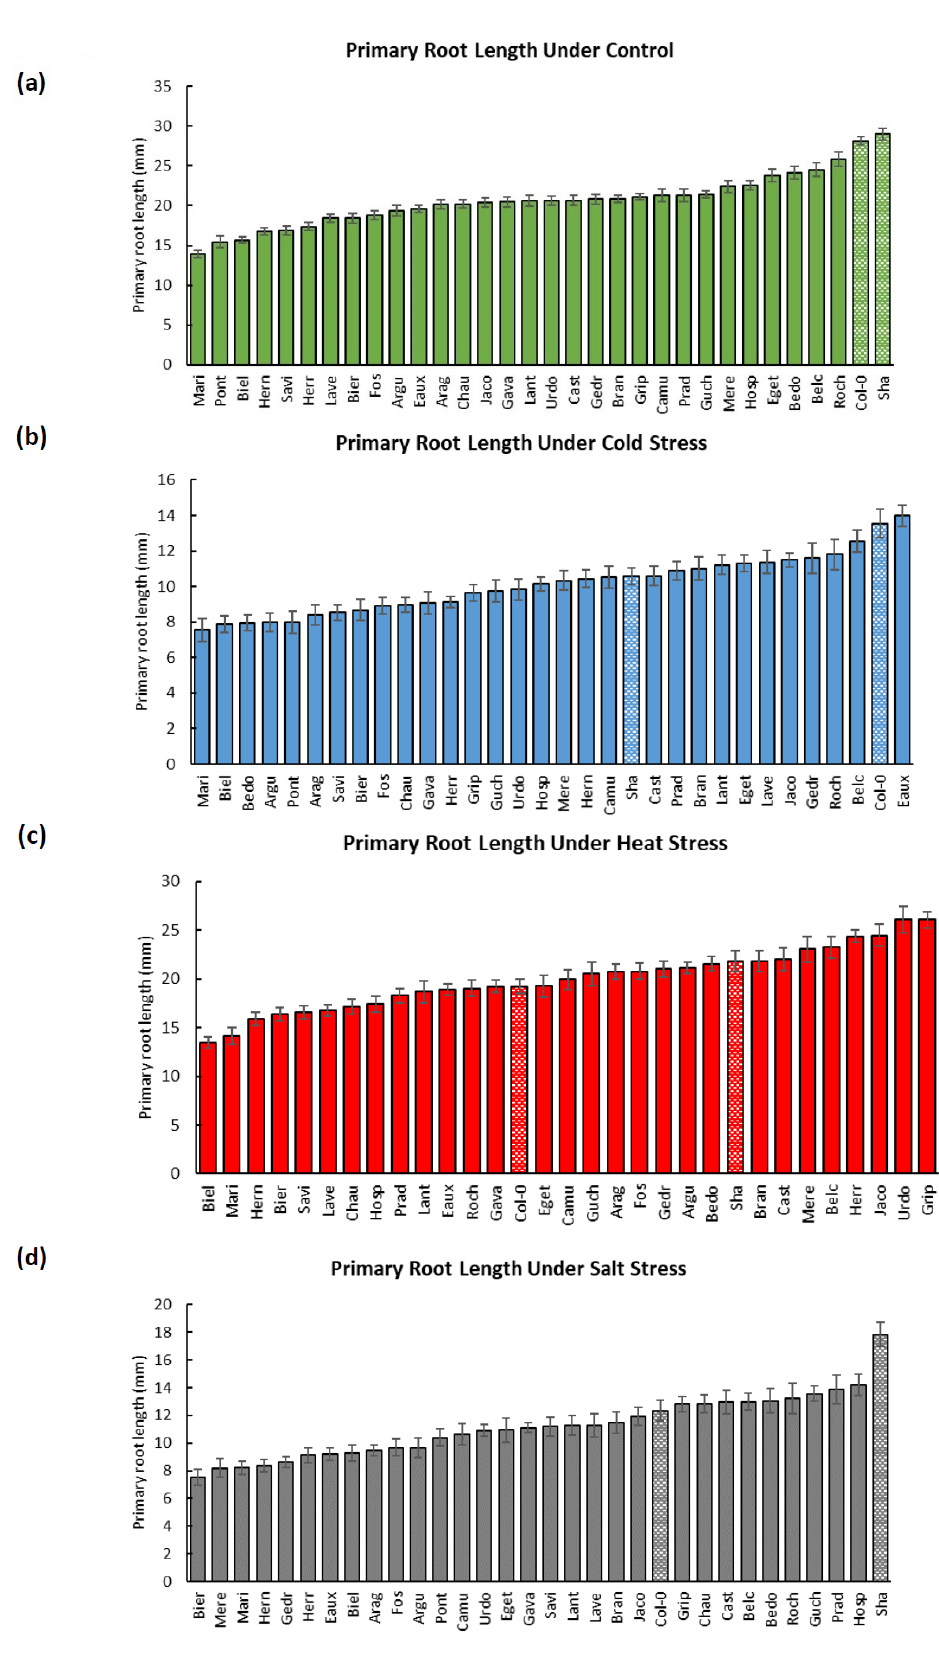
Figure A2. Bar graphs presenting the root growth rate (mm/day) of each population under each growth condition. The bar graphs are sorted in increasing order and those tiled in white correspond to Col-0 and Sha. The error bars correspond to the standard error of means.